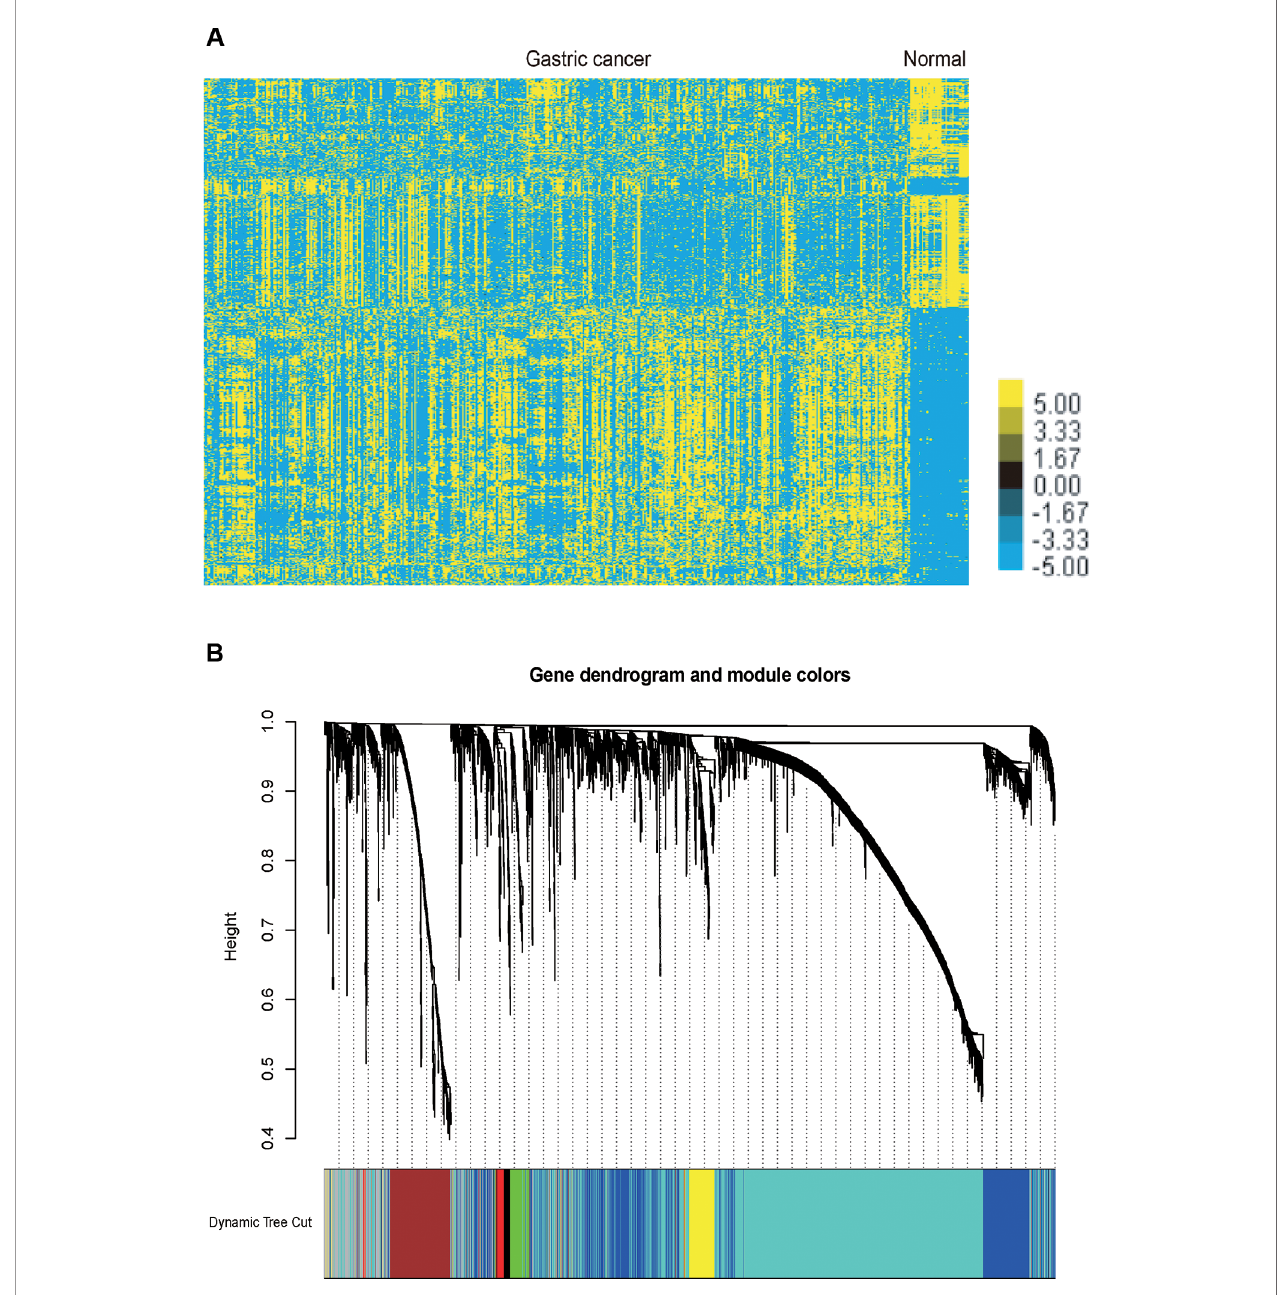
FIGURE 1 | Identi fi cation of the differentially expressed mRNAs and lncRNAs in GC and gene dendrogram. (A) Hierarchical clustering analysis indicating the differential mRNA and lncRNA expression in GC using TCGA database. Yellow indicates high expression and Blue indicates low expression. (B) Gene cluster dendrogram and module colours. Gene dendrogram obtained by Topological Overlap with the corresponding module colors indicated by the color row. Each color represents the independent module which contains a group of highly correlated genes. A total of 7 modules were identi fi